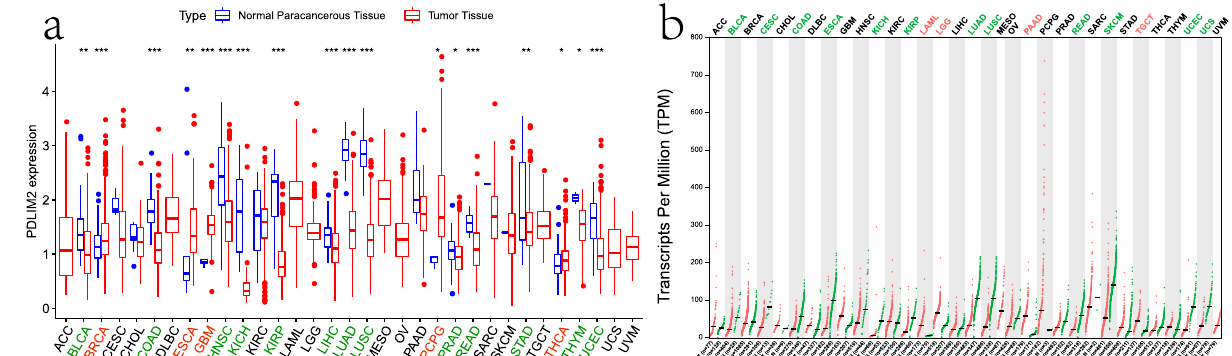
Figure 1. PDLIM2 expression levels in different tumor types ( a ) from TCGA database . The red fusiformis represents tumor tissue and the blue fusiformis represents normal tissue;the p values are indicated as *P < 0.05, **P < 0.01, ***P < 0.001; ( b ) from GEPIA2 database(http:// gepia2. cancer- pku. cn/# analy sis). Words marked in red refer to tumor types highly expressed in cancerous tissues, words marked in green refer to tumor types highly expressed in paracancerous tissues. ACC: adrenocortical carcinoma; BLCA: bladder urothelial carcinoma; COAD: colon adenocarcinoma; HNSC: head and neck squamous cell carcinoma; KICH: kidney chromophobe; KIRP: kidney renal papillary cell carcinoma; LIHC: liver hepatocellular carcinoma; LUAD: lung adenocarcinoma; LUSC: lung squamous cell carcinoma; PRAD: prostate adenocarcinoma; READ: rectum adenocarcinoma; STAD: stomach adenocarcinoma; THCA: thyroid carcinoma; UCEC: uterine corpus endometrial carcinoma; THYM: thymoma; BRCA: breast invasive carcinoma; ESCA: esophageal carcinoma; GBM: glioblastoma multiforme; PCPG: pheochromocytoma and paraganglioma (for interpretation of abbreviations in this figure legend, the reader is referred to the supplementary table of this